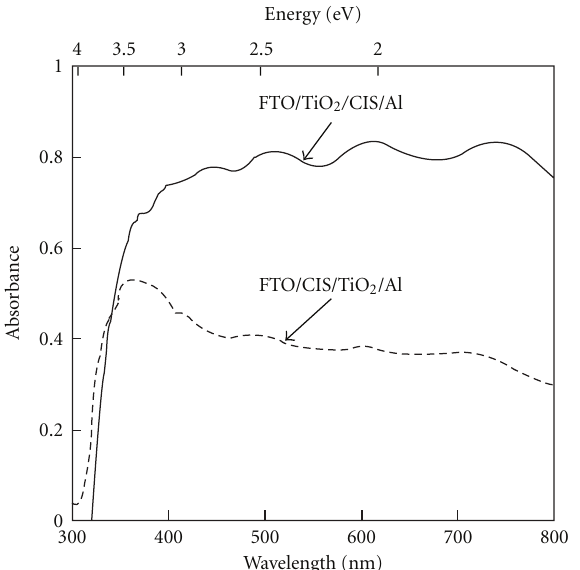
Figure 2: Optical absorption of CIS/TiO 2 heterojunction solar cells.